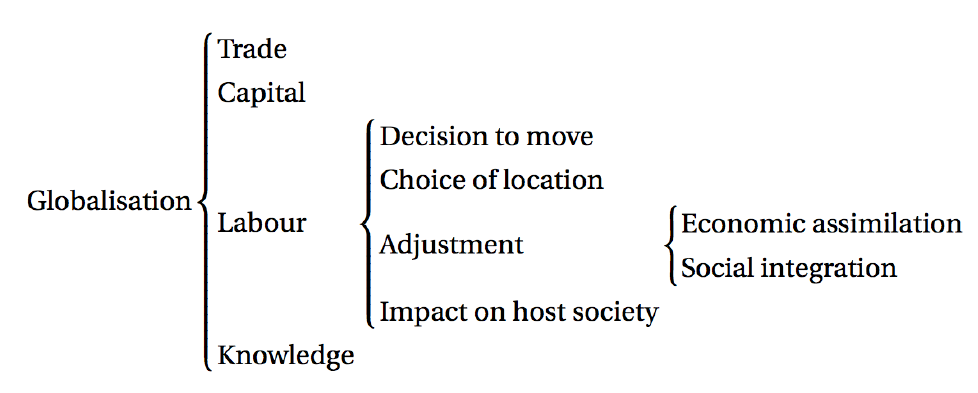
Figure 1: Niche of Research in this